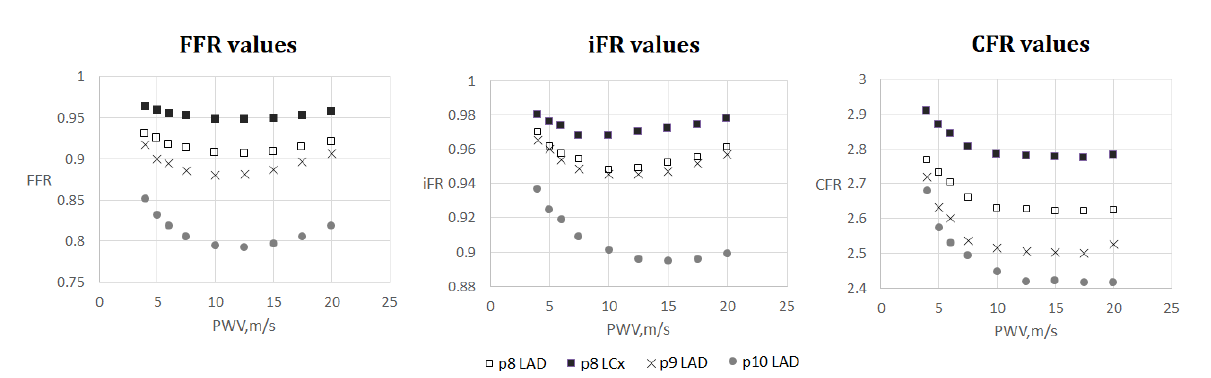
Figure 7. FFR, iFR and CFR sensitivity to AoPWV for patients from 8 to 10. Patient 8 had two stenoses located in the left anterior descending artery (LAD) and the left circumflex artery